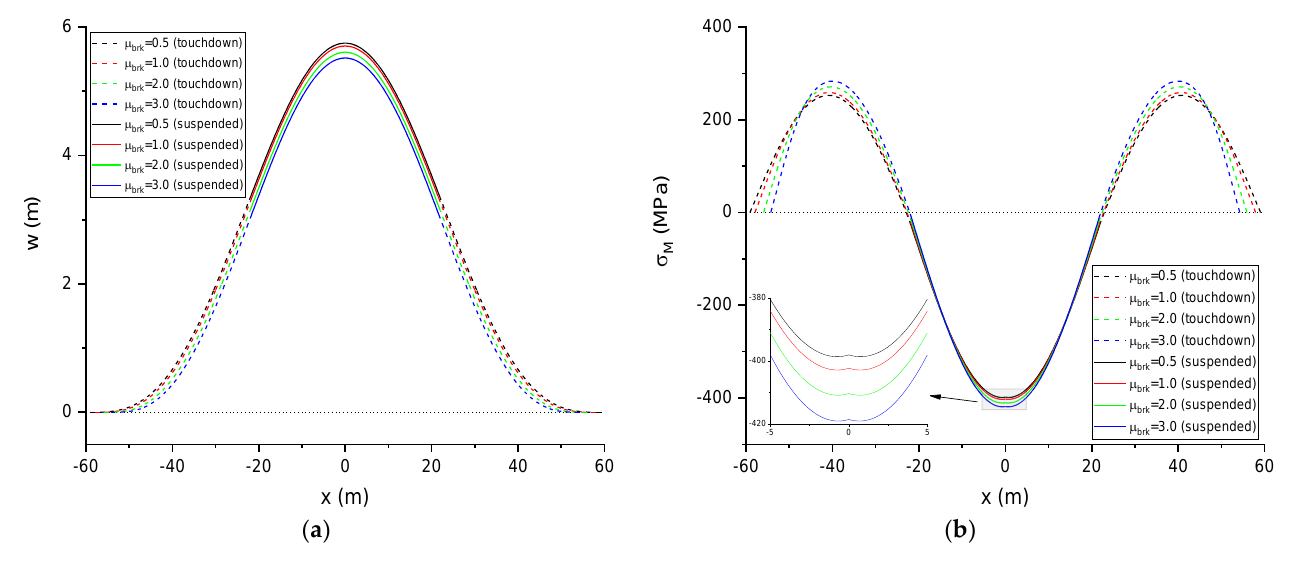
Figure 7. Influence of 𝜇 𝑏𝑟𝑘 on configurations. ( a ) Deformed shapes. ( b ) Bending stresses ( 𝑣 𝑜𝑚 = 0.1 m, 𝜇 𝑠 = 0.1 , 𝑇 0 = 40 °C ).